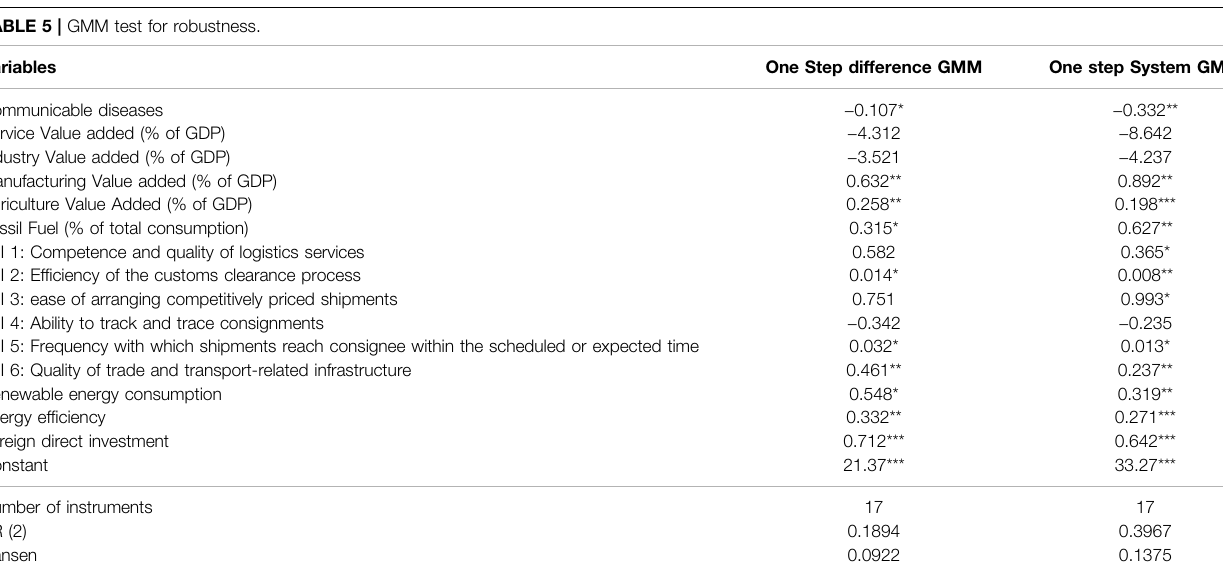
TABLE 5 | GMM test for